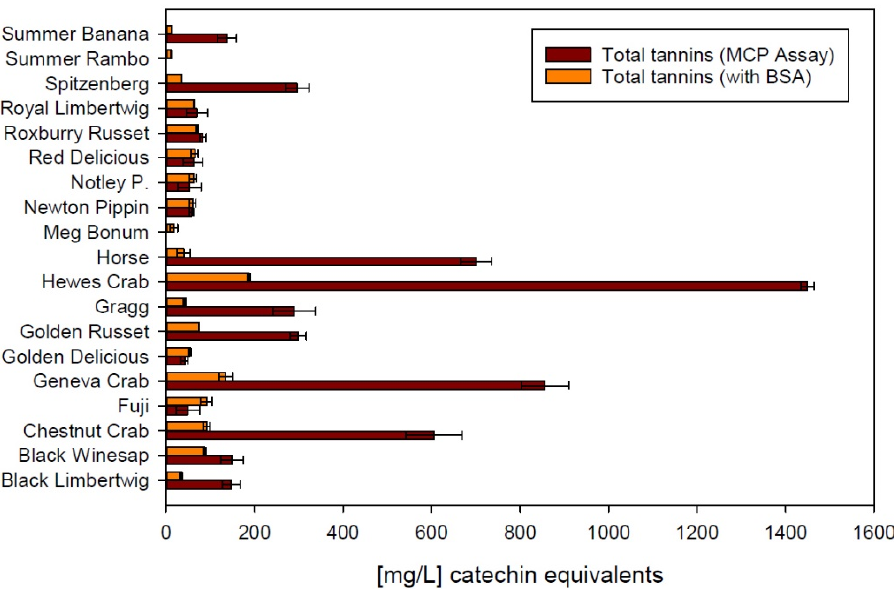
Figure 4. Comparison between methylcellulose (MCP Assay) and bovine serum albumin (BSA) in the same spectrophotometric tannin precipitation assay. Error bars represent analytical standard deviation.